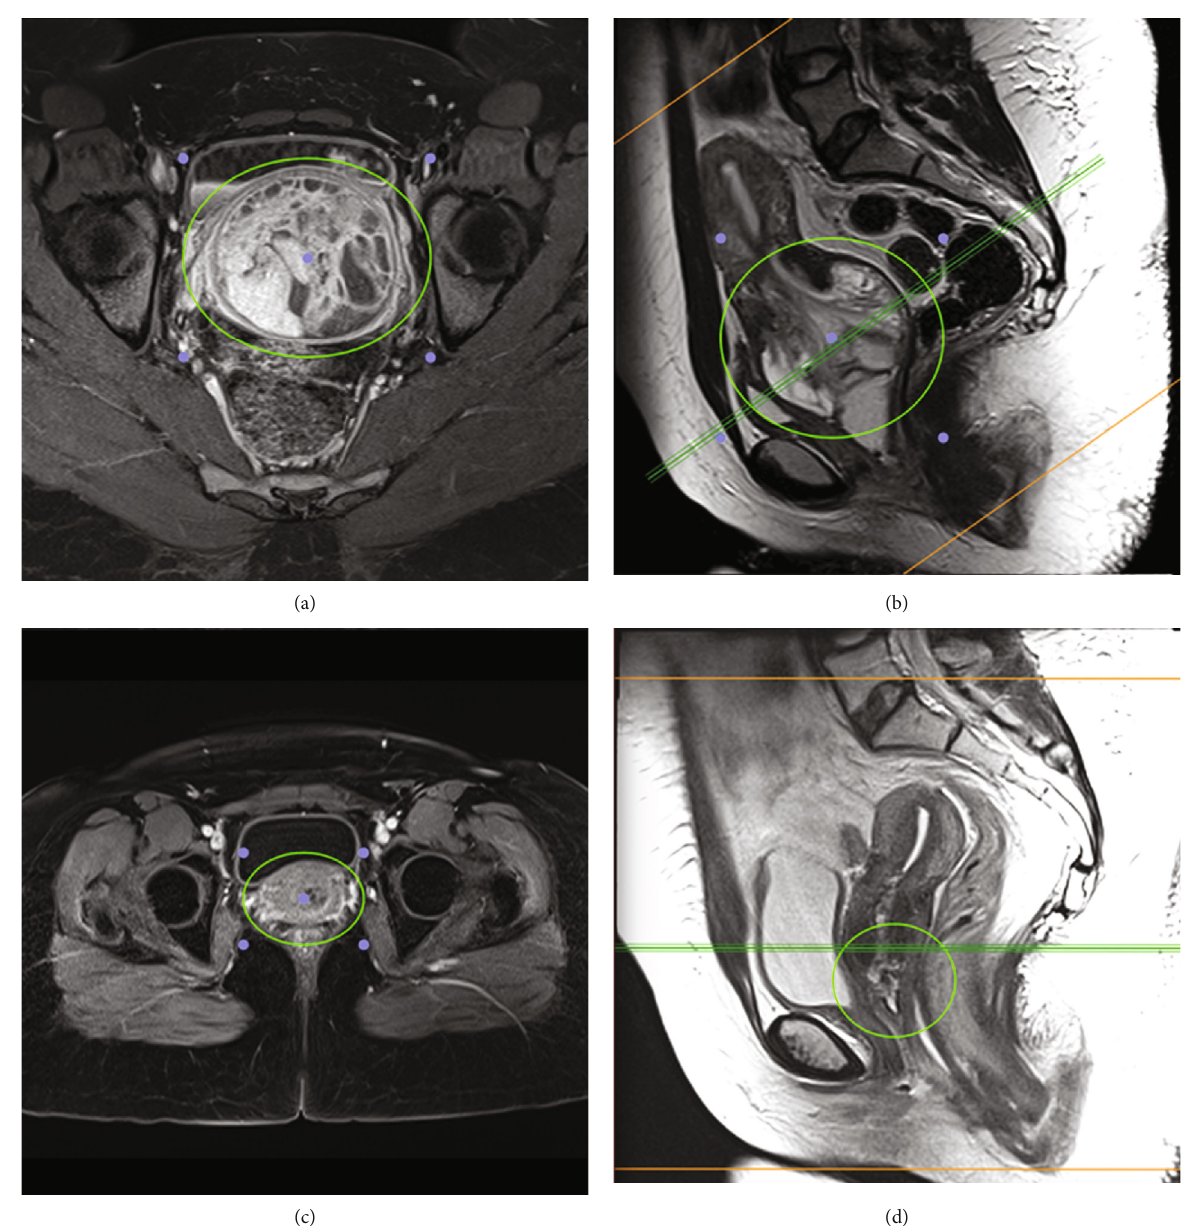
Figure 2: (a, b) MRI of the pelvis (axial and sagittal views) before neoadjuvant chemoradiotherapy demonstrating a heterogeneously enhanced well-circumscribed lesion measuring 3 : 2 cm ð ap Þ × 6 : 1cm ð tr Þ con fi ned within the middle compartment of the pelvis. There is association with distention of the forniceal and transitional compartments of the vagina with caudal displacement of the introitus. (c, d) MRI of the pelvis after neoadjuvant chemoradiotherapy demonstrated a signi fi cant decrease in the volume of the lesion which measured 1 : 3cm ð ap Þ × 1 : 2cm ð tr Þ remaining con fi ned within the middle compartment of the pelvis. The residual disease is epicentred in the upper third of the vagina with cranial extension into the cervical and lower endometrial